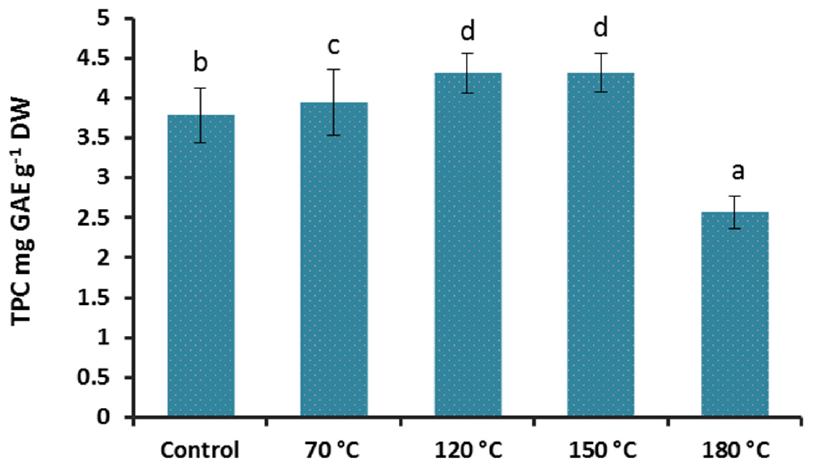
Figure 2. Total phenolics content (mean ± StDev) in Reishi mushroom ( G. lingzhi ) basidiocarp after heat treatment. Different letters are for statistically different values (Tukey’s post hoc test, p < 0.05).